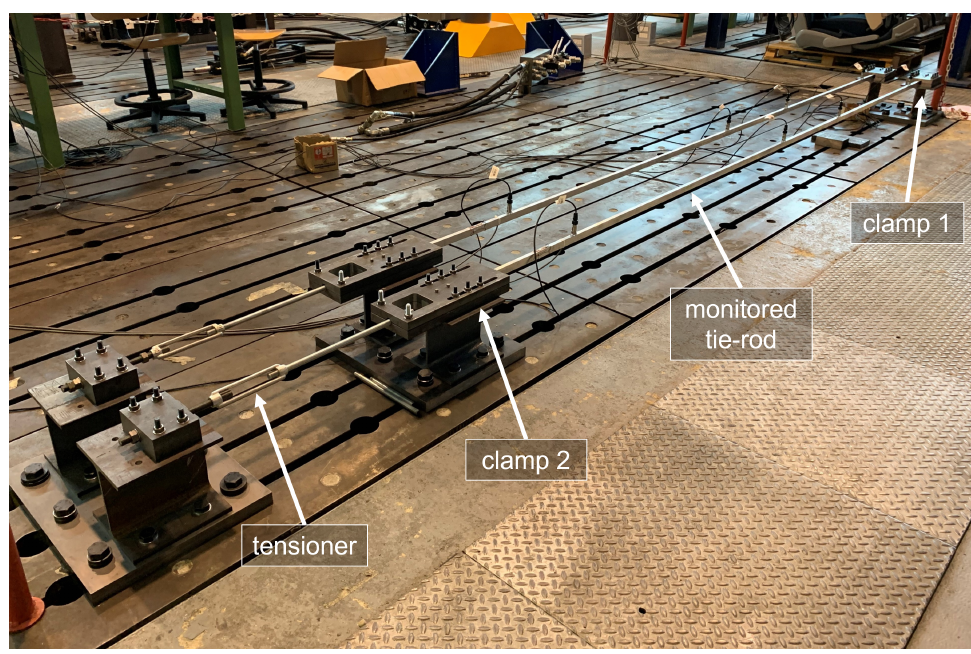
Figure 3. The experimental